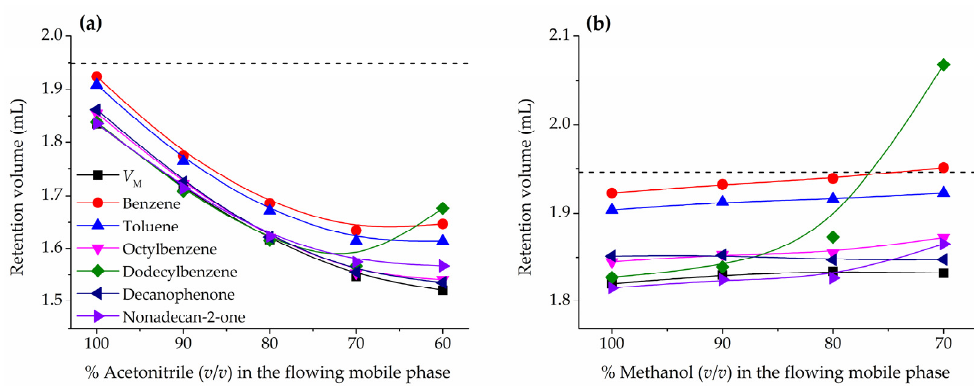
Figure 2. Variation of the retention for HILIC hold-up volume marker candidates with the composition of the mobile phase in the ZIC-HILIC column: ( a ) acetonitrile/water and ( b ) methanol/water mobile phases. The hold-up volume ( V M ) obtained from the homologous series approach (black squares) and the pycnometrically measured solvent volume ( V solvent ) (dashed straight line) are also plotted.